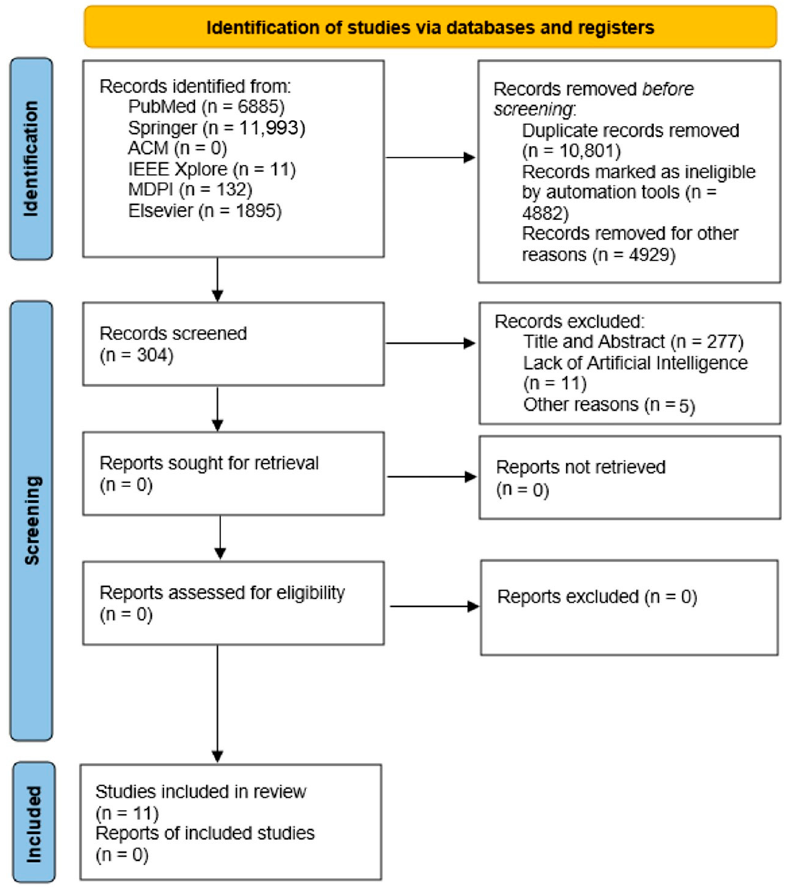
Figure 1. Flow Diagram.